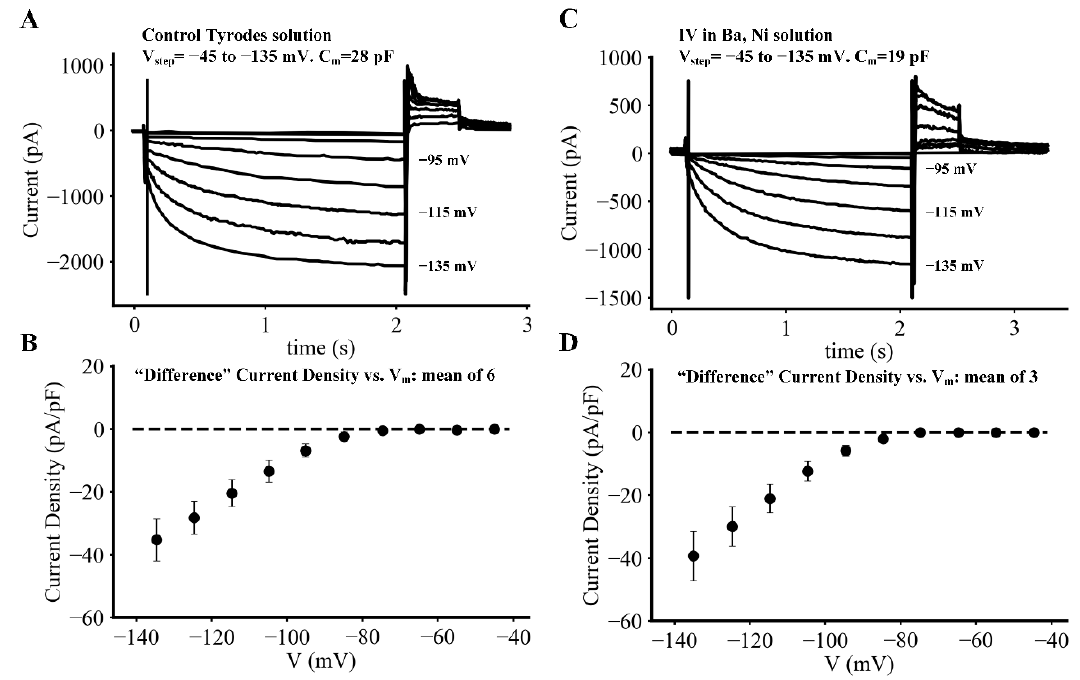
Figure 4. General properties and reversal potential measurements for the hyperpolarization-acti- vated current, I f , in adult mouse SAN pacemaker myocytes. ( A , B ): Transmembrane current records and I–V in control Tyrodes solution. ( C , D ): Transmembrane current records and I-V in Ba, Ni